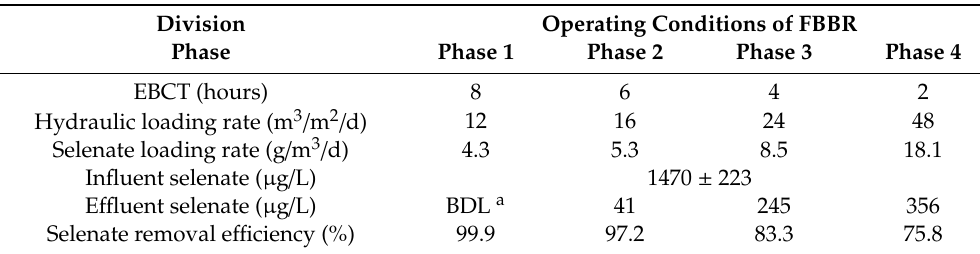
Figure 2. Variation of effluent selenate concentration according to the selenate loading rate and EBCT during phases 1 to 4. Table 2. Effluent selenate concentration and selenate removal efficiency obtained in an FBBR according to the selenate loading rate.